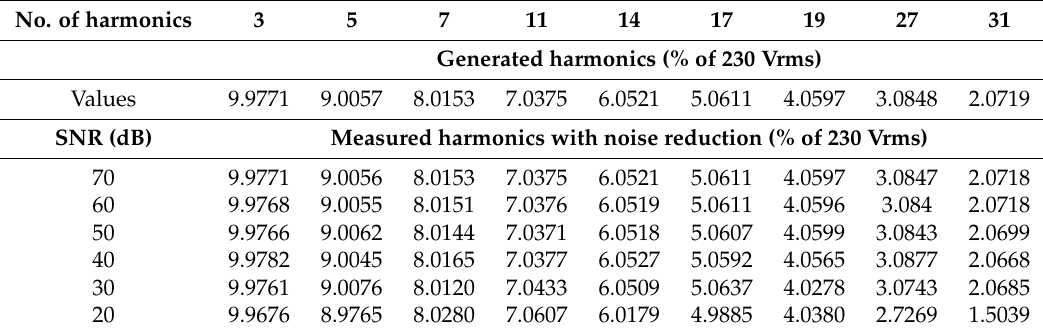
Table 3. Values of generated and measured signal harmonic as % of signal